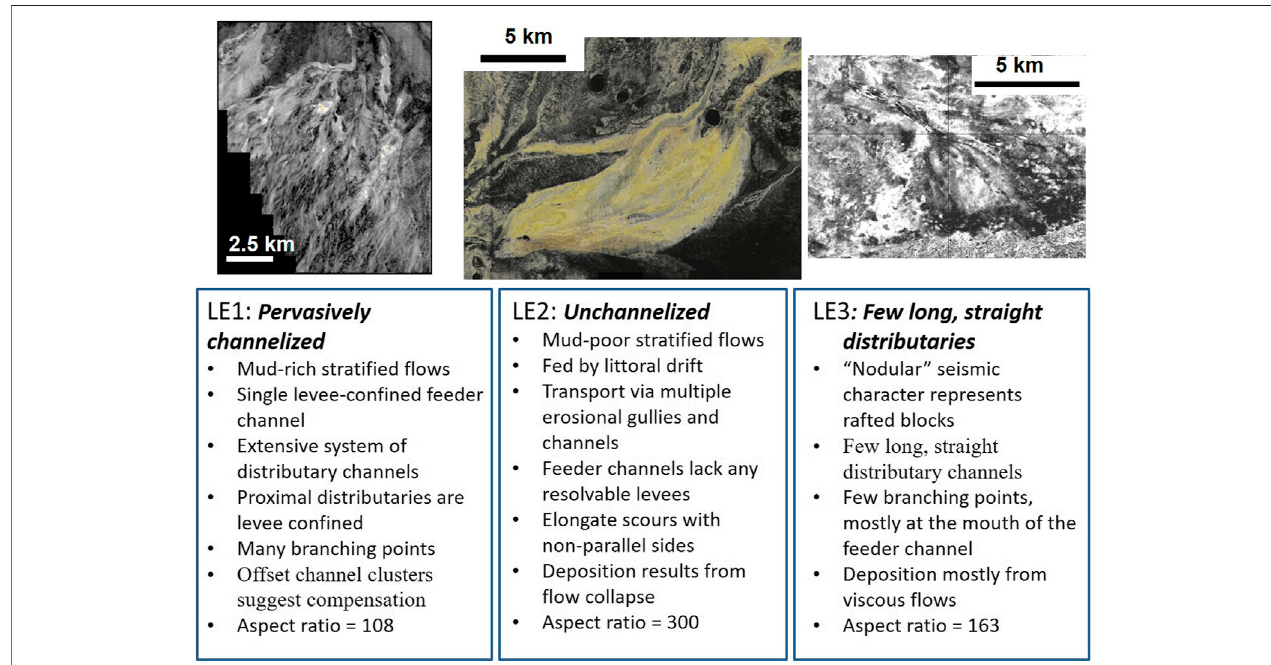
FIGURE 10 | Summary of distinctive characteristics of the three discussed lobate examples. See Figures 2 , 6 , 8 for explanations of seismic RMS amplitude displays.